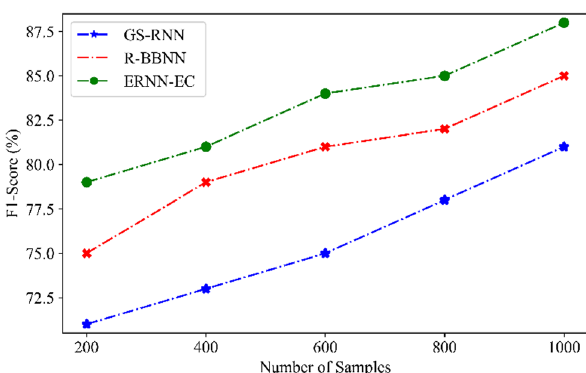
Figure 6: Comparison of F 1 -